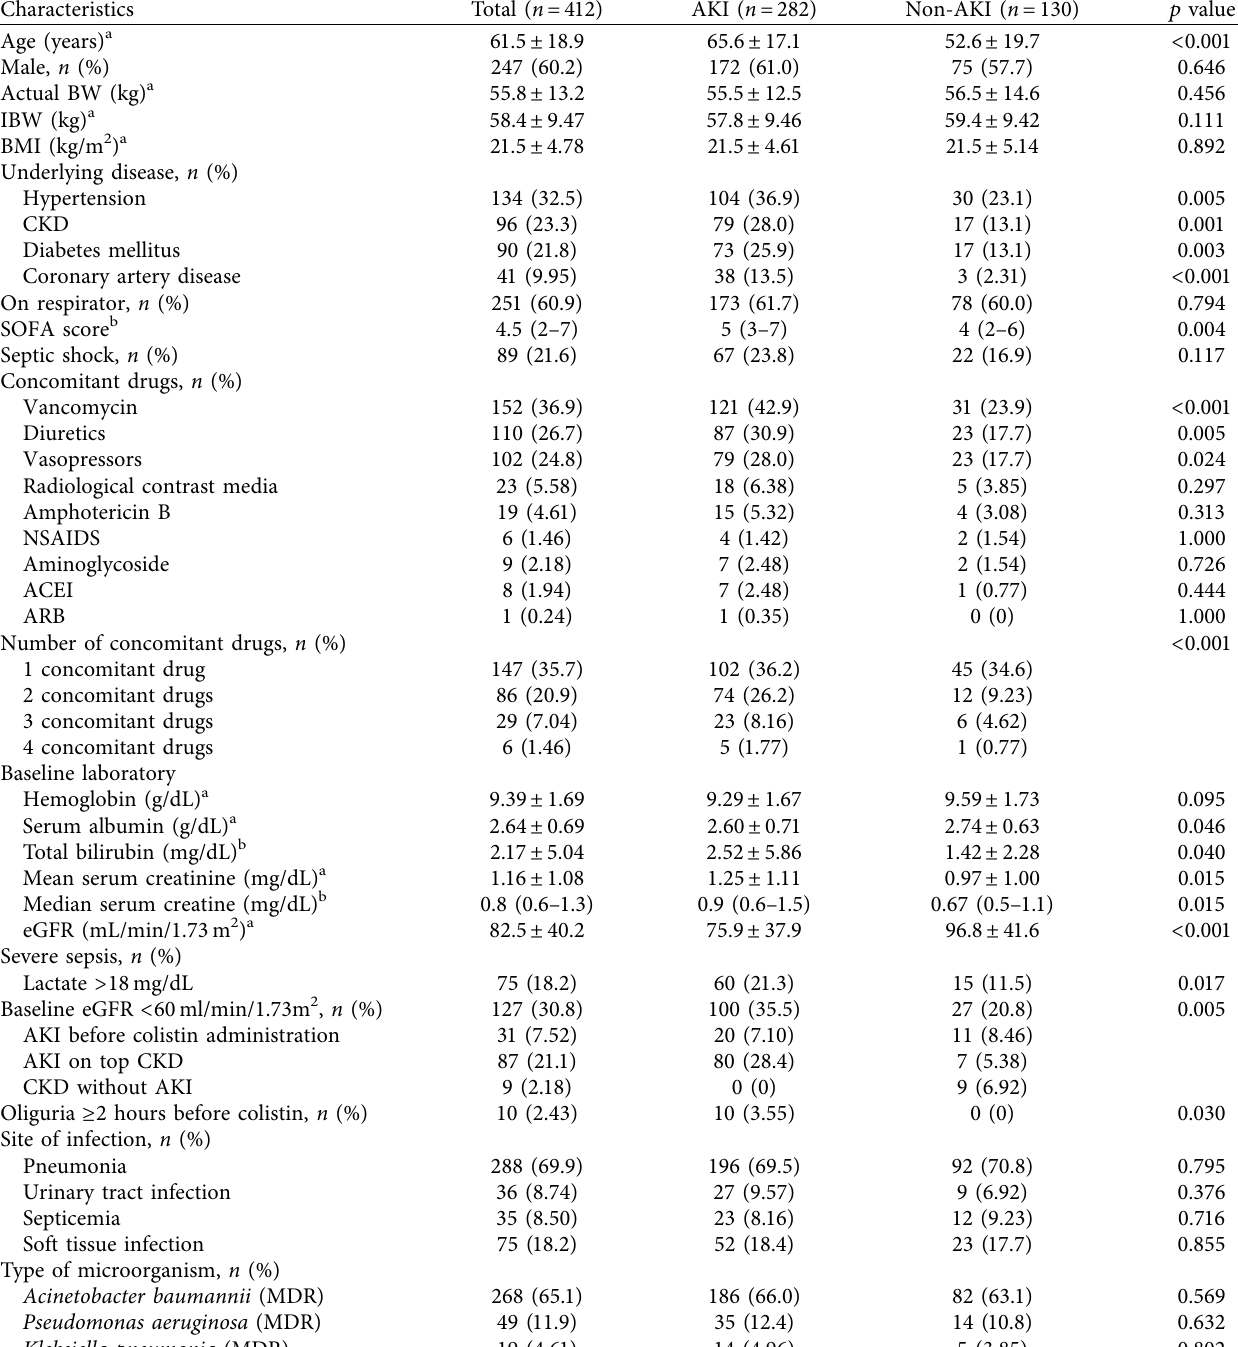
Table 1: Demographic data, baseline characteristics of patients with and without AKI during colistin treatment.